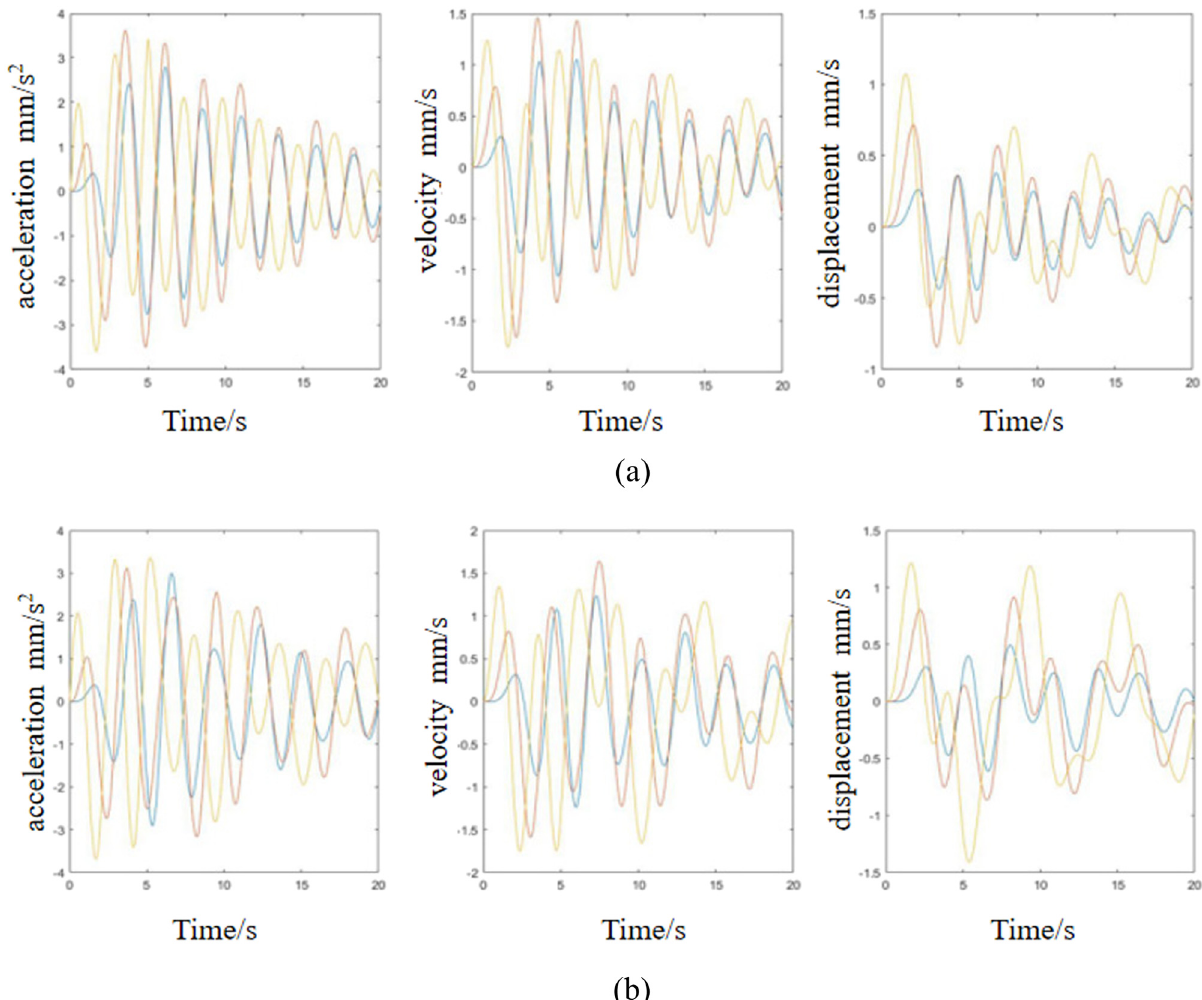
Figure 5: Velocity, displacement, and acceleration with di ff erent reduction coe ffi cients of bottom load: ( a ) sti ff ness reduction factor is 1 and ( b ) sti ff ness reduction factor is